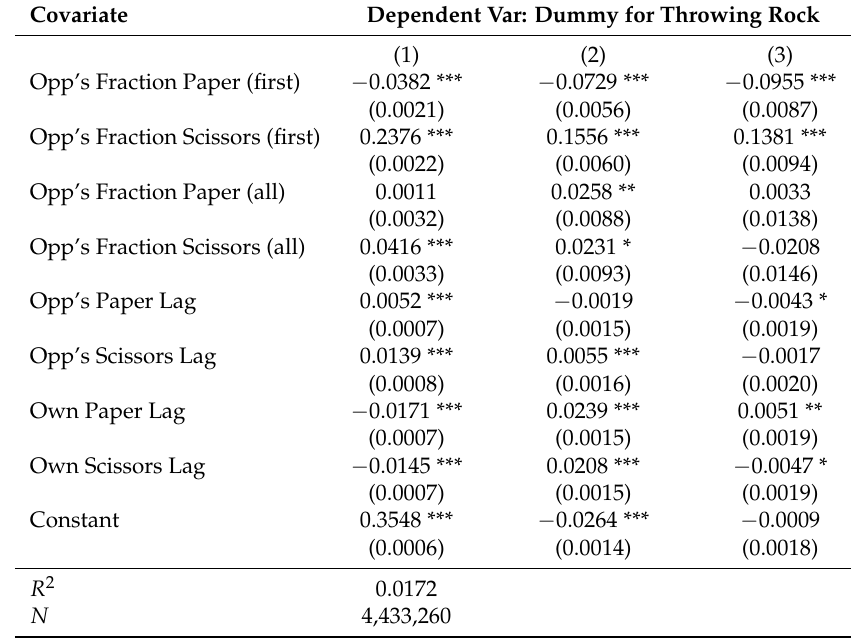
Table 3. Probability of Playing